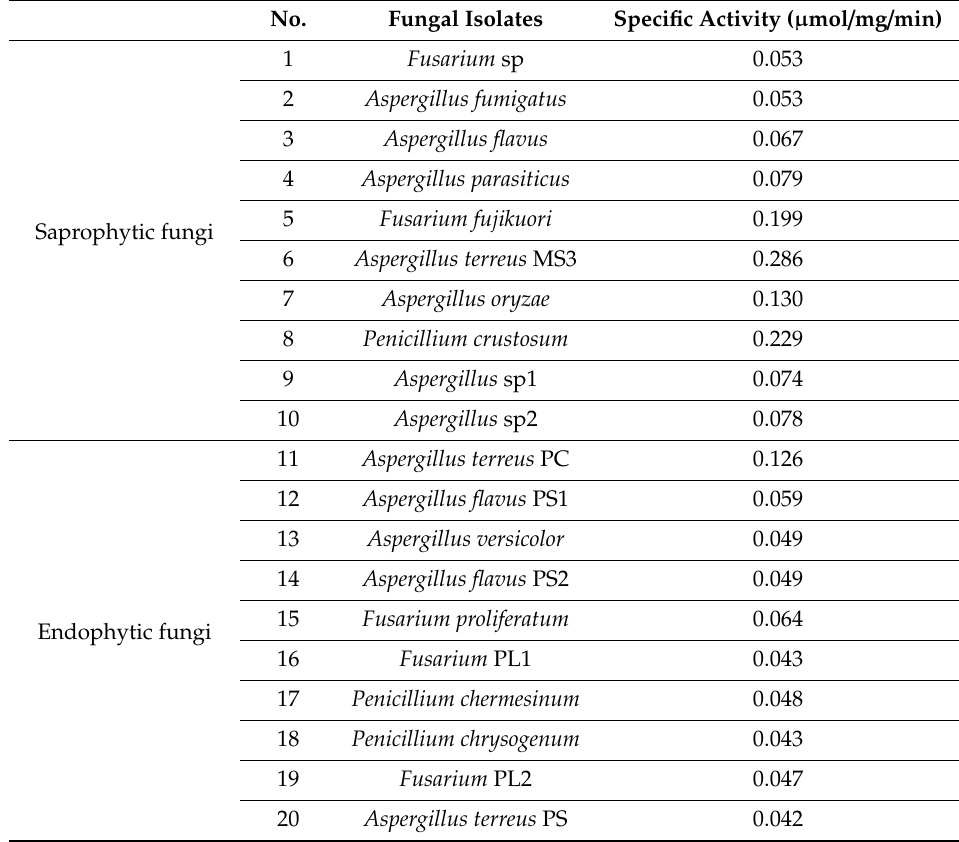
Table 1. Activity of ornithine decarboxylase from the selected saprophytic and endophytic fungal